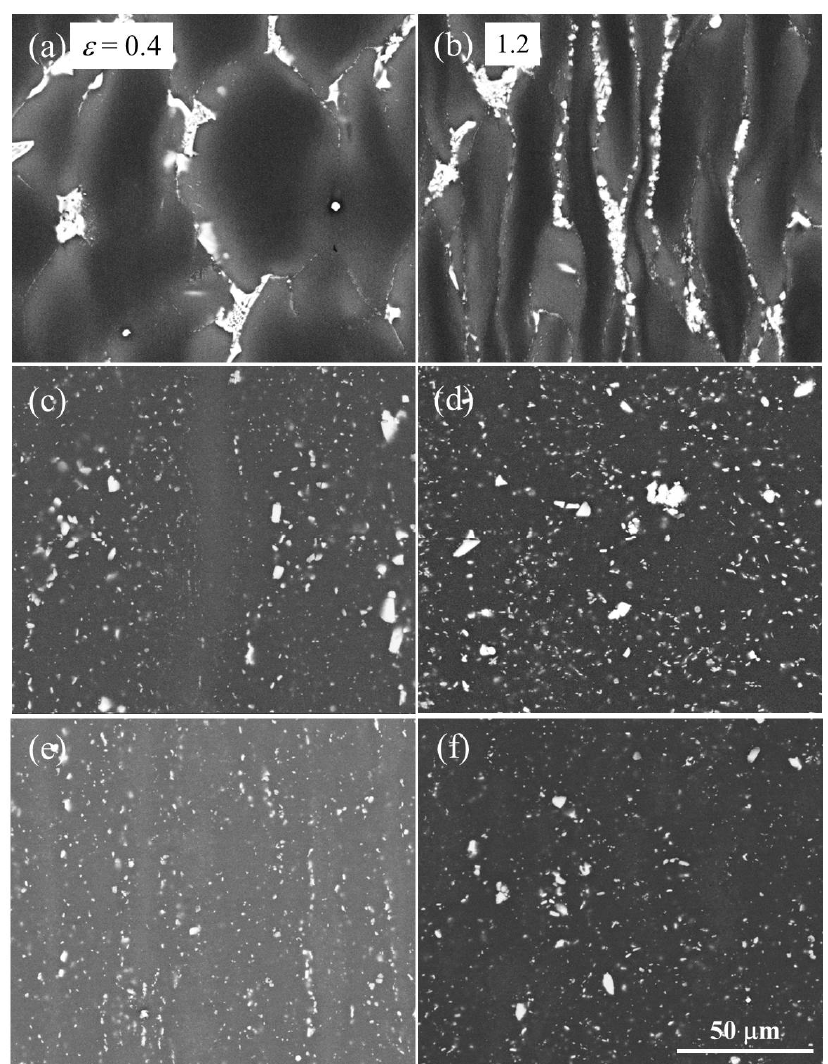
Figure 10. Typical SEM microstructures after compressed at a strain rate of 0.05 s -1 with different true strains of 0.4 and 1.2 for (a, b) AC, (c, d) Ex-1 and (e, f) Ex-2 WE43 alloy, respectively. strains of 0.4 and 1.2 for (a, b) AC, (c, d) Ex-1 and (e, f) Ex-2 WE43 alloy,